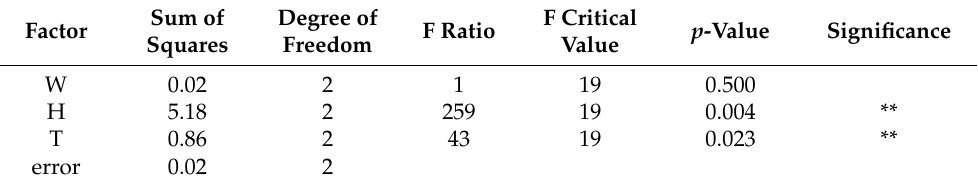
Table 7. Radial oven-dry shrinkage variance of impregnated heat-treated